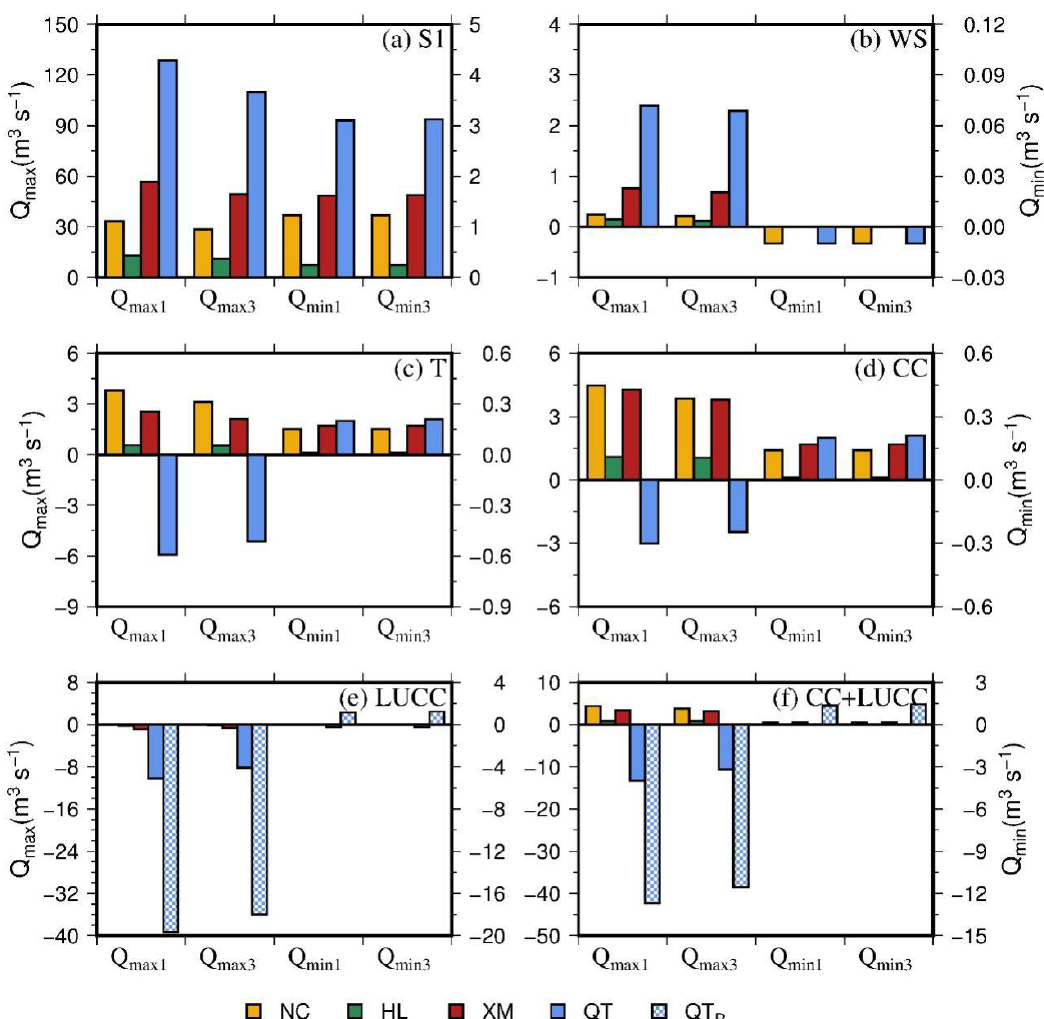
Figure 6. Extreme streamflow indices (left y -axis represents Q max1 and Q max3 , right y -axis represents Q min1 and Q min3 ) under baseline scenario ( a ) and the impacts of wind speed change ( b ), temperature change ( c ), climate change ( d ), land use/cover change ( e ), and both climate change and land use/cover change ( f ).